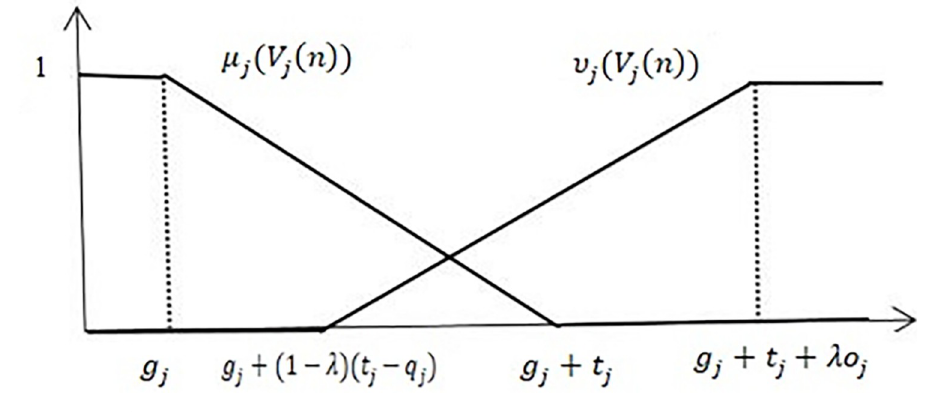
Fig 1. MF and Non-MF.